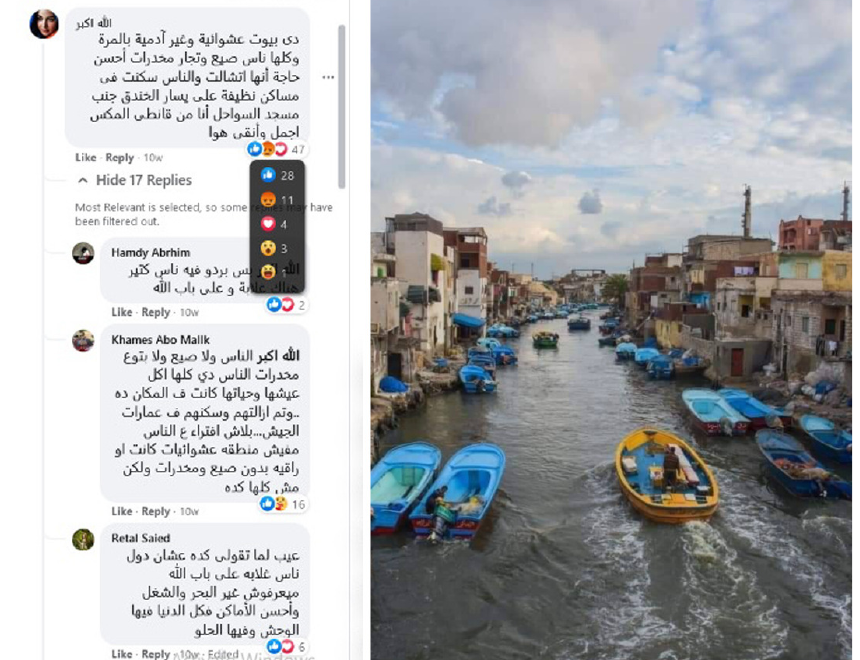
Figure 5. A screenshot for a picture of Al‐Max and the comments section on a Facebook post that showed the fishing village before the